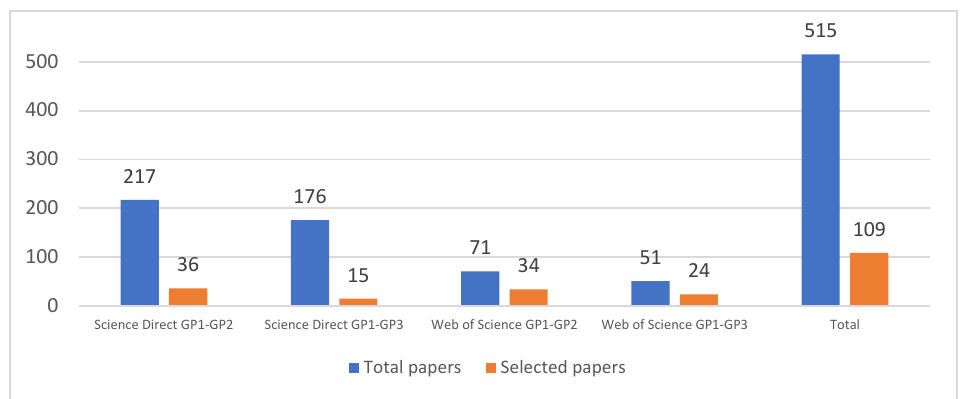
Figure 1. Distribution of the extracted papers by publication year.